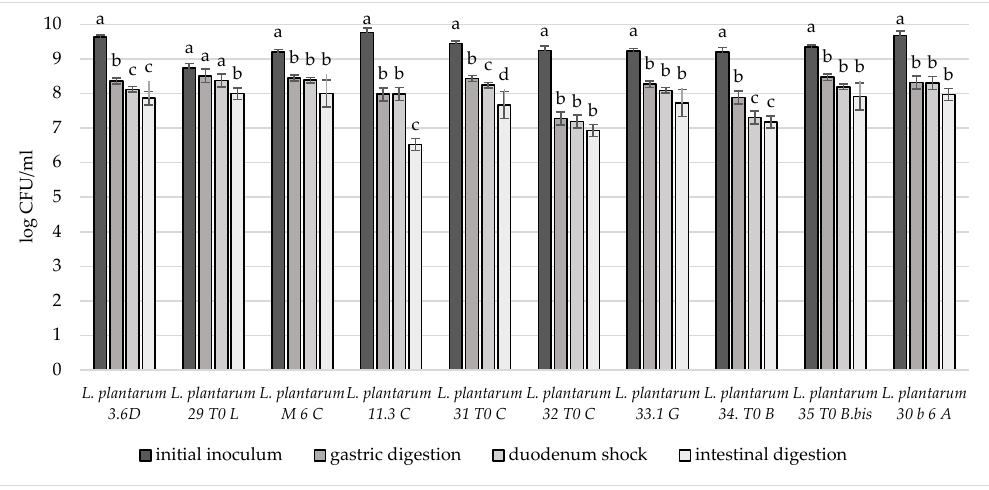
Figure 4. Cell loads of L. plantarum 3.6D, 29 T0 L, M 6 C, 11.3 C, 31 T0 C, 32 T0 C, 33.1 G, 34 T0 B, 35 T0 B.Bis, 30 b6 A after the simulated stomach–duodenum passage, performed immediately after the inoculation in milk. Samples with different letters are significant different ( p < 0.05).